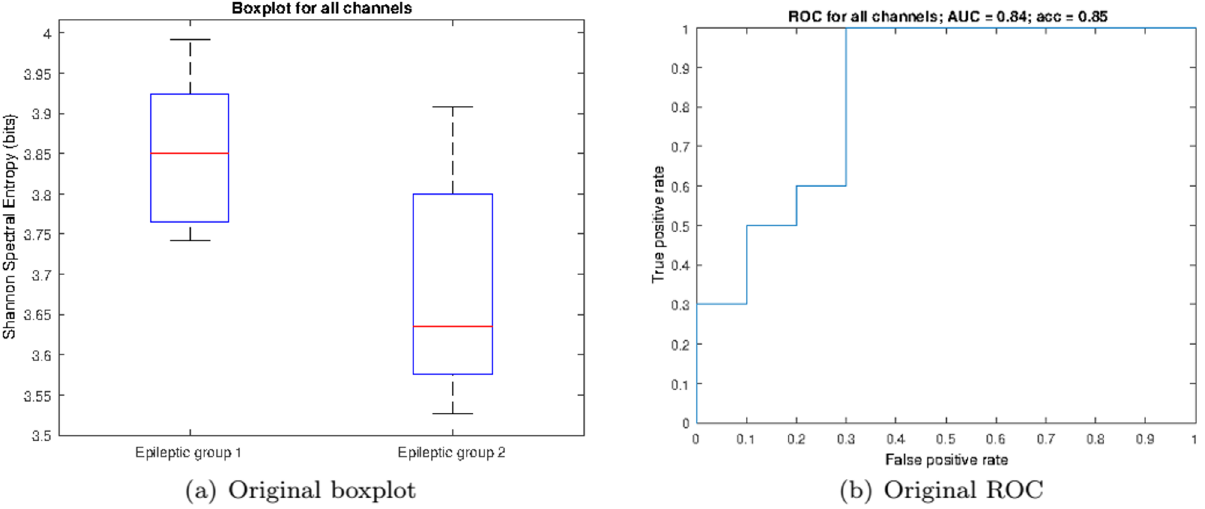
Fig 5. Classification analysis based on all significant electrodes. (a) Boxplot and (b) ROC curve correspondingto the classification analysisof the two groups of epileptic patients. Red lines in the boxes mark the medianand edgesthe 25th and 75th percentiles of the data.